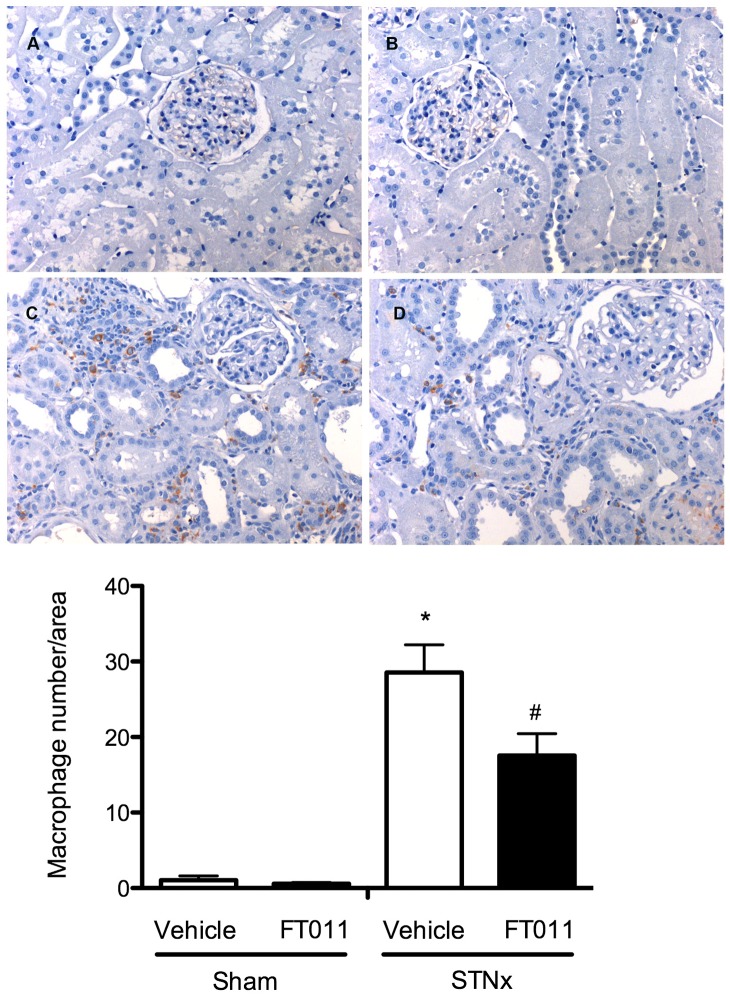
Representative photomicrograph of ED-1 staining from STNx rats.Representative photomicrographs of ED-1 immunostained sections from sham and STNx rats treated with or without FT011. In sham (A) and sham treated with FT011 (B) rats, only occasional macrophages were observed in the interstitium, while STNx rats (C) were associated with numerous macrophages. Treatment of STNx animals with FT011 (D) was associated with a reduction in macrophage number. Magnification x200. Quantitative data are expressed as mean ± SEM. *P<0.05 versus sham; #P<0.05 versus vehicle treated STNx rats.